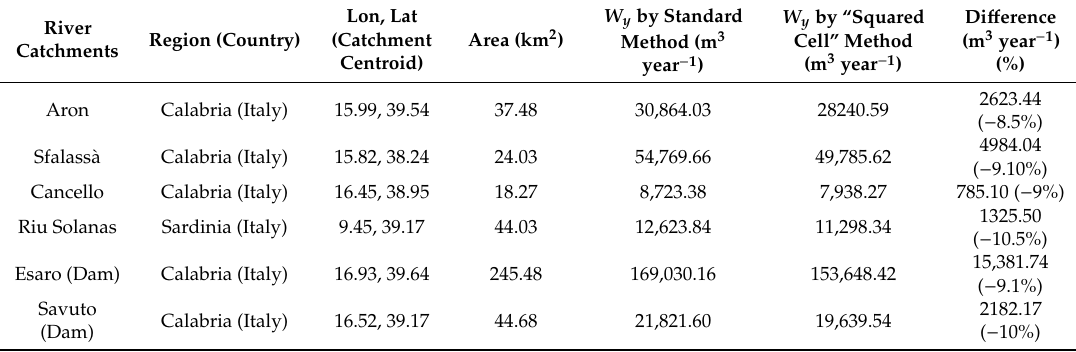
Table 4. Results of sediment yield between standard and squared cell method on some river